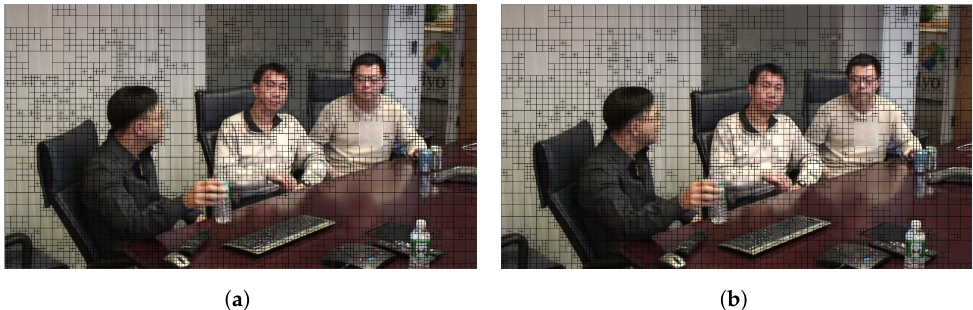
Figure 11. CU partition results of various algorithms. ( a ) Partition of Vidyo1 by using HM16.22. ( b ) Partition of Vidyo1 by using our